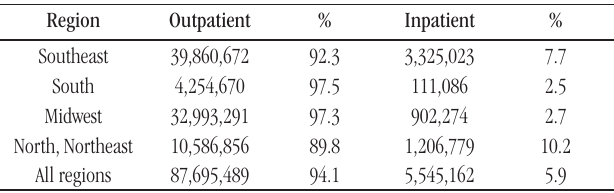
taBLE 1 – Absolute numbers and their rates of tests performed by 81 laboratories from 1 May, 2016 to 1 May, 2017, by type of environment and by geographical region